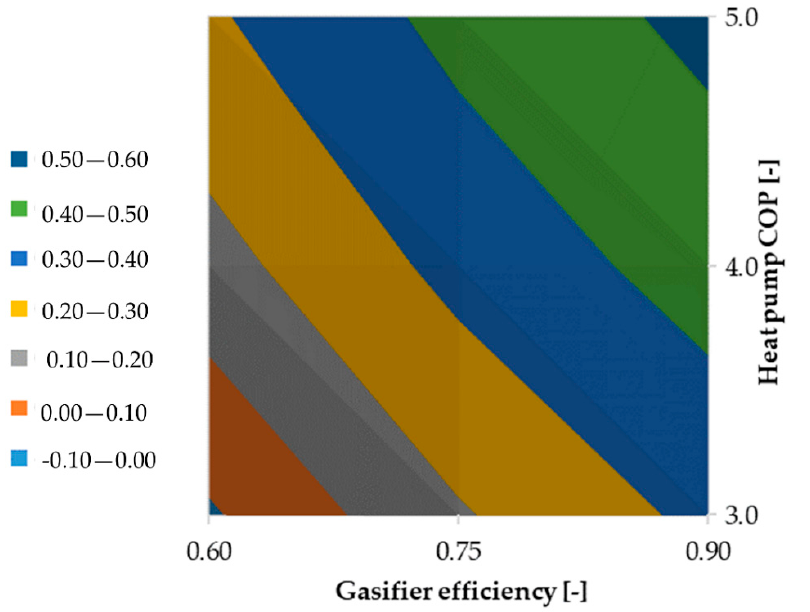
Figure 29. PES as a function of gasifier efficiency and heat pump COP.